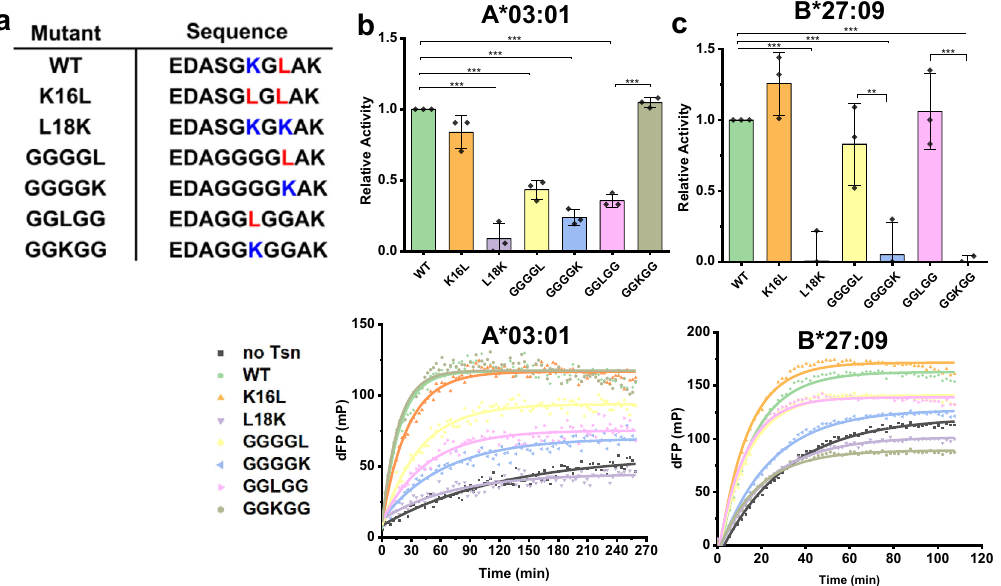
Fig. 4 The role of K16 is the F-pocket nature dependent. a The sequence of Tsn loop 11 – 20 mutants . b , c upper panel: Relative activity of tapasin loop 11 – 20 mutants to catalyze peptide exchange compared to ERp57-Tsn WT towards A*03:01 and B*27:09. FTIC-KK9 was used for A*03:01, FTIC-IF9 (IRAAK FITC PPLF) was used for better resolution of B*27:09. Error bars (SD) were calculated from three independent experiments. For comparison of loop mutants to WT, the two-sample unequal variance Student ’ s t test was performed (* p < 0.05, ** p < 0.01, *** p < 0.001). Lower panel: Representative peptide exchange pro fi les of 500 nM A*03:01/photoKK9, and B*27:09/photoRL9 in the absence (black) and presence of equimolar amounts of tapasin loop mutants. dFP means the baseline was subtracted. These curves were recorded on the PerkinElmer VICTOR 3 V both mutants. The binding groove residues signi fi cantly affected by ERp57-Tsn GGLGG and ERp57-Tsn L18G overlapped largely with residues affected by ERp57-Tsn WT (Fig. 5b, the red boxed region).